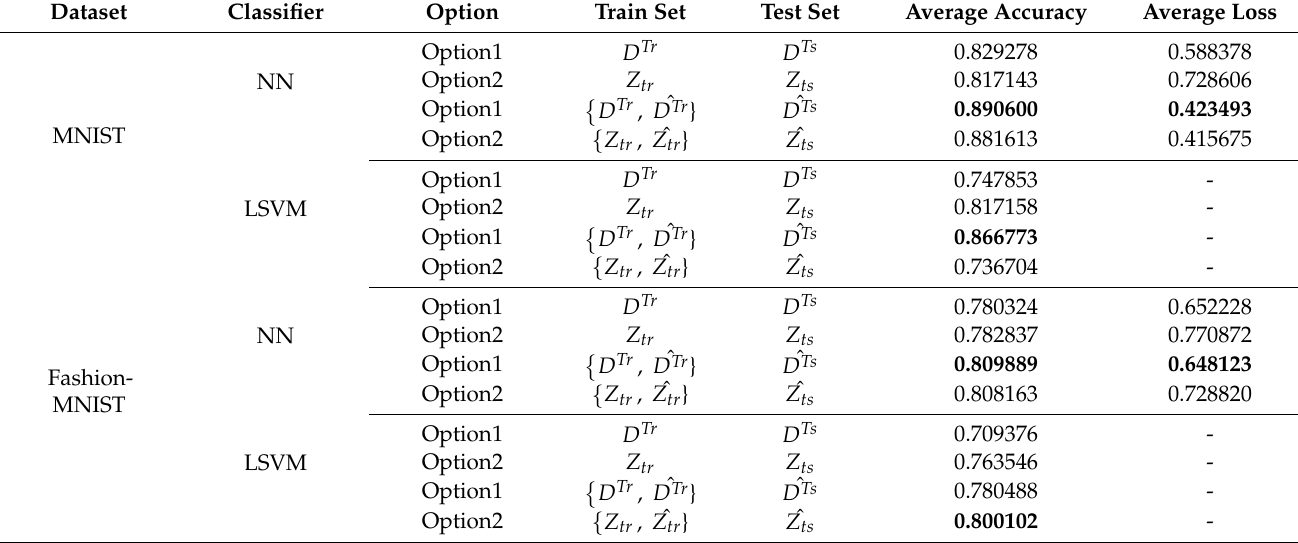
Table 7. Set-2 pilot experiment classification setting results. Bolded values indicate the comparison result between the two options. D Tr is the original training set (without transformation) and { D Tr , ˆ D Tr } is the original training D Tr set augmented with the transformed (using our model) training set ˆ D Tr . { Z tr , ˆ Z tr } is the features extracted from the autoencoder of the original training set D Tr augmented with the extracted features of the transformed training set ˆ D Tr ,